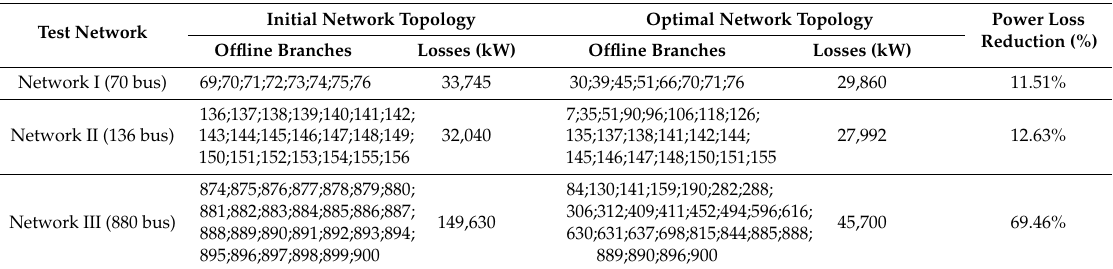
Table 2. Initial and optimal network topology for 70, 136 and 880 bus network.